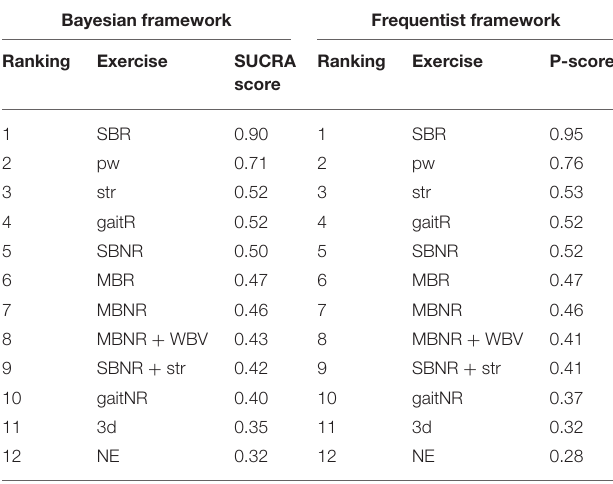
TABLE 5 | Ranking of exercise interventions in healthy older adults. Bayesian framework Frequentist